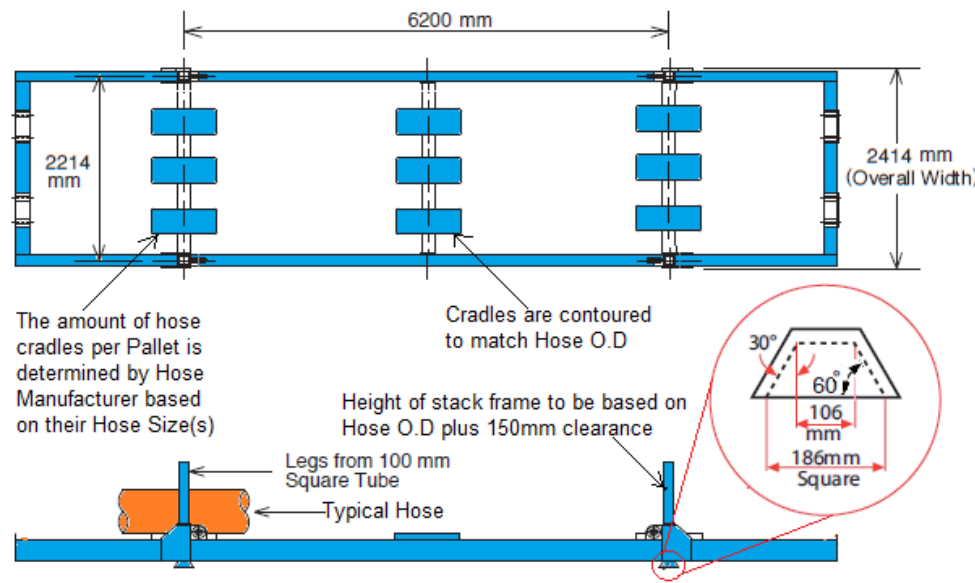
Figure 33. Packing pallet with the array for marine hoses.